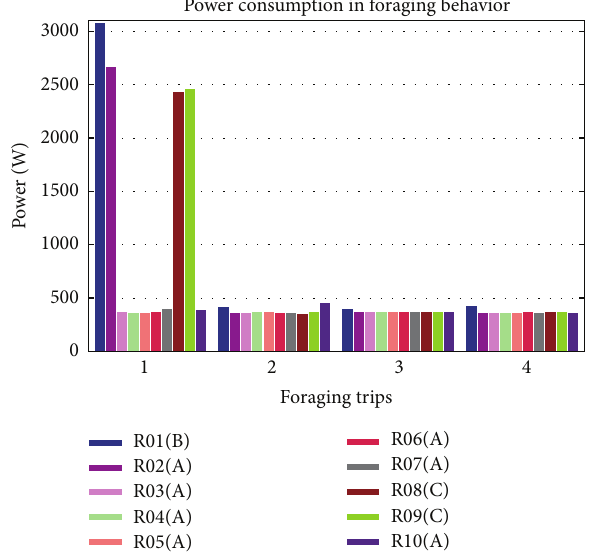
Figure 11: Foraging power